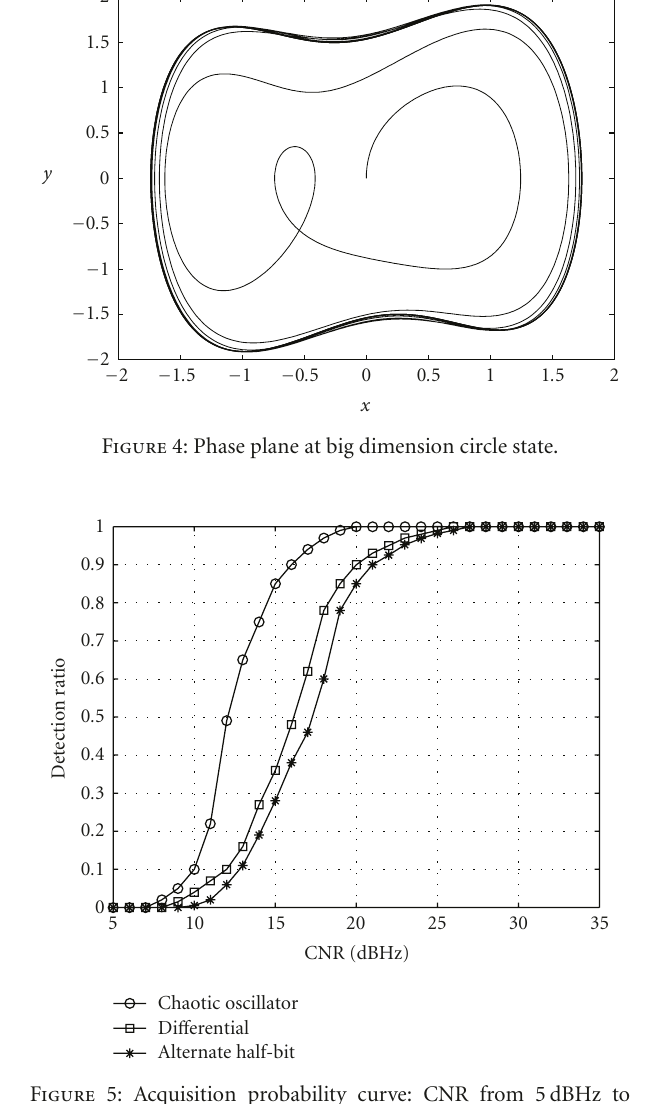
Figure 5: Acquisition probability curve: CNR from 5dBHz to